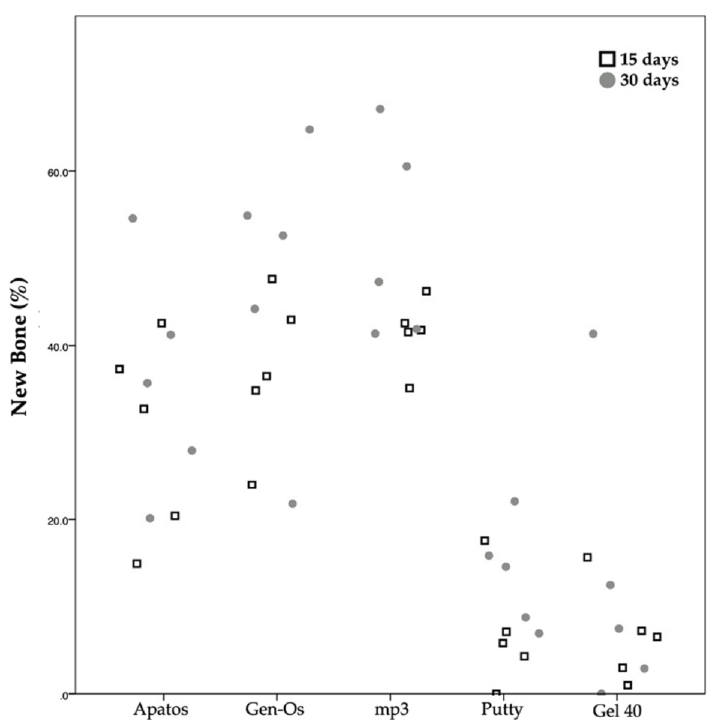
Figure 7. Scatter plot graph displaying the percentage of new bone measurements for different materials and at the two assessment times.